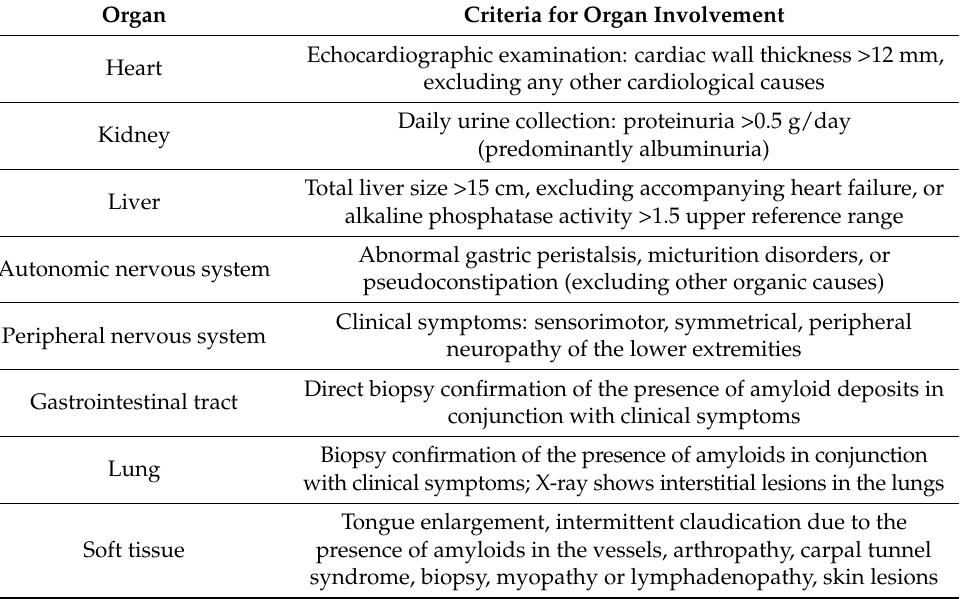
Table 1. Criteria for organ * involvement in systemic immunoglobulin light chain amyloidosis (AL amyloidosis) according to Gertz et al. [13,14].